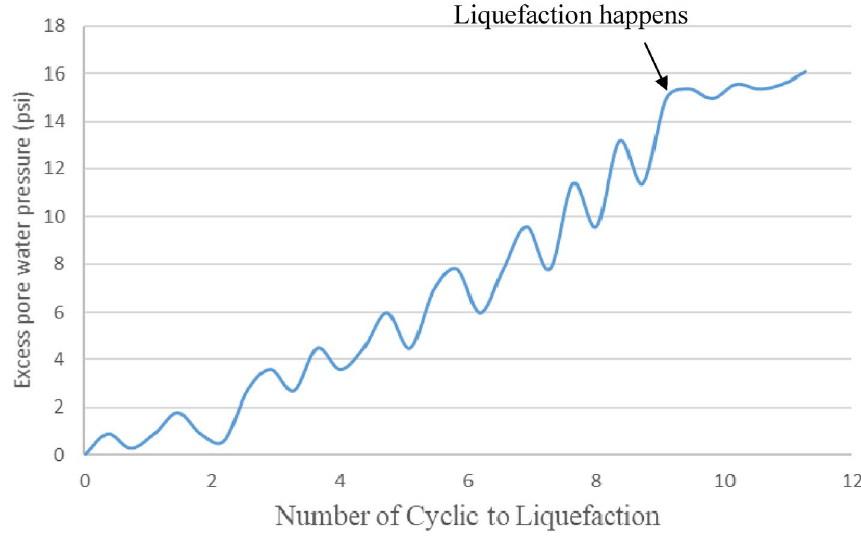
Figure 10. Pore water pressure change versus number of cycles to liquefaction in cyclic triaxial test.